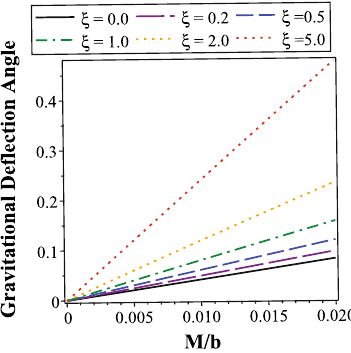
Fig. 2 The gravitational deflection angles in acoustic Schwarzschild black hole for several ξ values. The horizontal axis labels the M / b and theverticalaxislabelsthegravitationaldeflectionangle α .Inthisfigure, the gravitational deflection angles are plotted in region 0 ≤ M / b ≤ 0 . 02, which correspond to the cases of weak gravitational